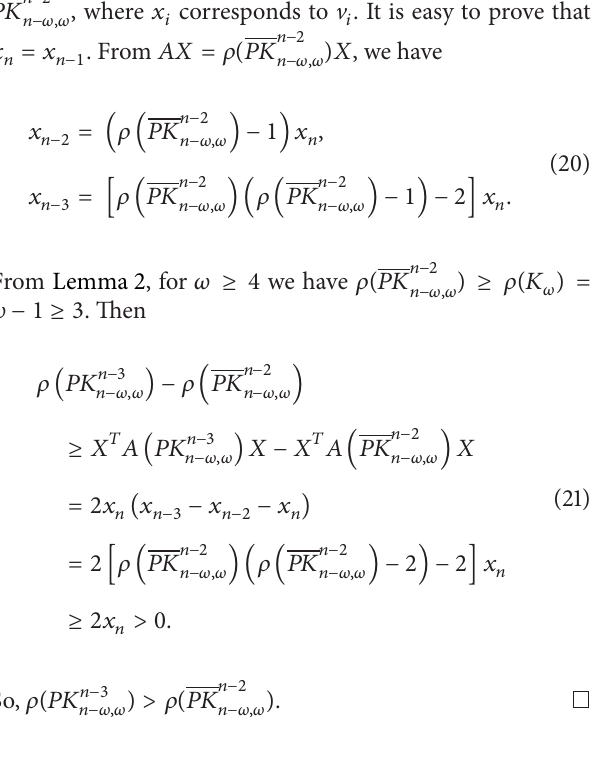
Figure 8: Graph 𝑀 2 𝜔